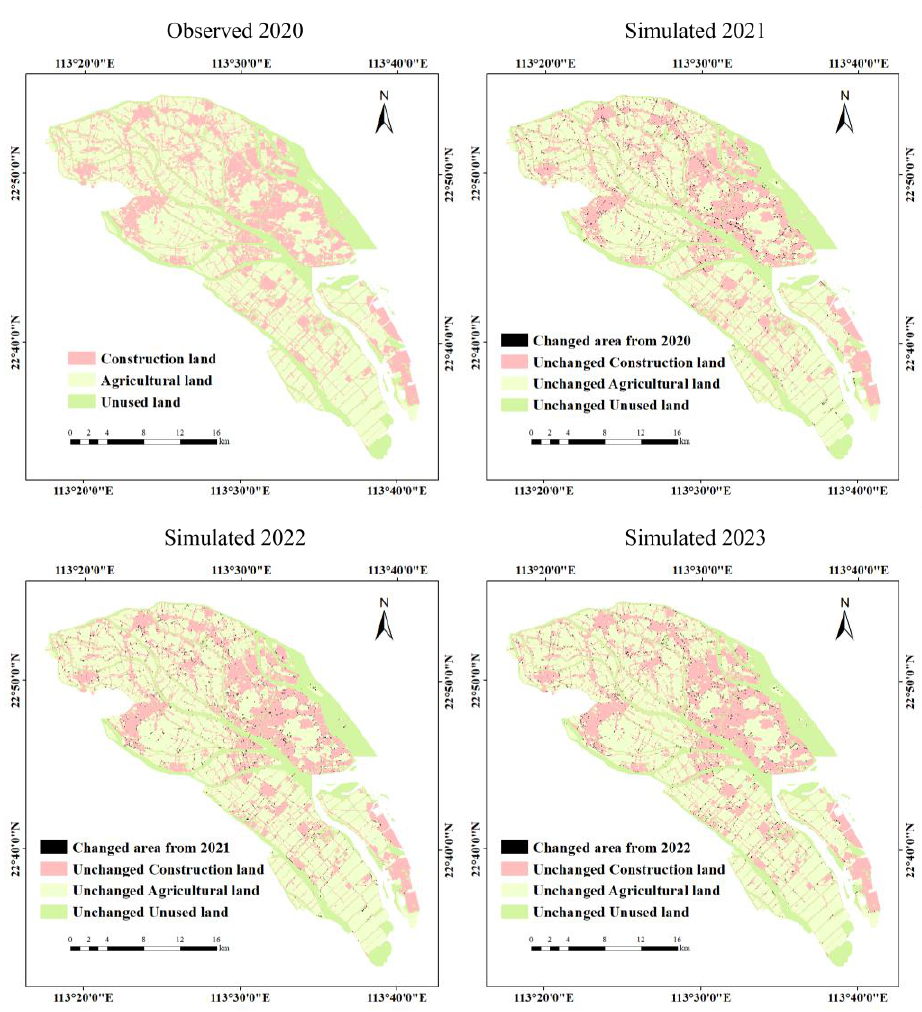
Figure 7. Land use maps in Nansha for 2020 (observed), 2021 (simulated), 2022 (simulated), and 2023 (simulated).